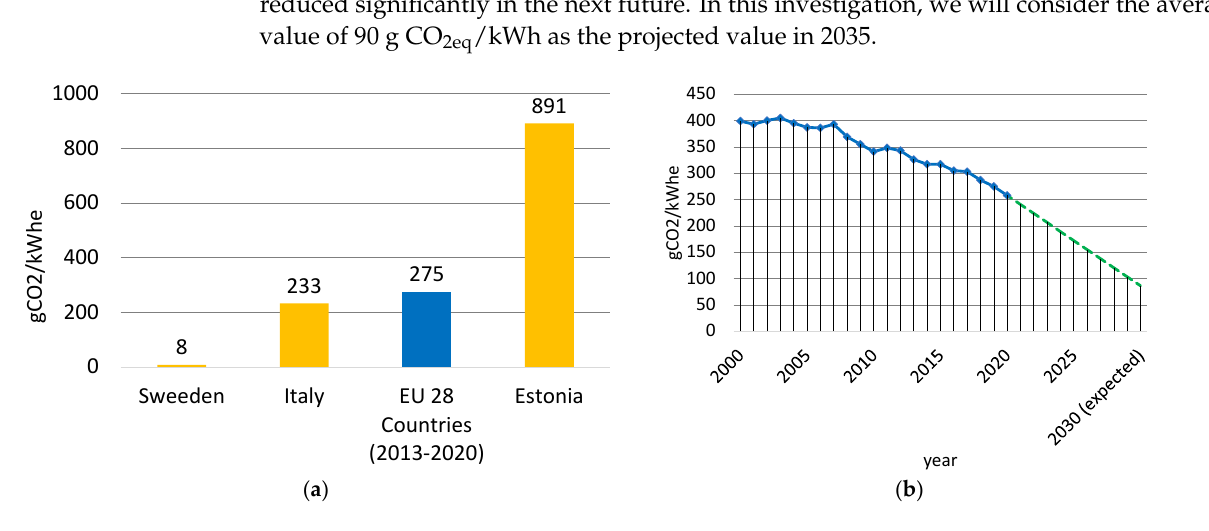
Figure 3. Past, present, and future emission intensity of European countries (elaboration of data from www.eea.europa.eu (accessed on 22 August 2021)). ( a ) Greenhouse Emission intensity in Europe (2019); ( b ) the trend of Greenhouse Emissions intensity vs. years (average value for EU 28 countries).